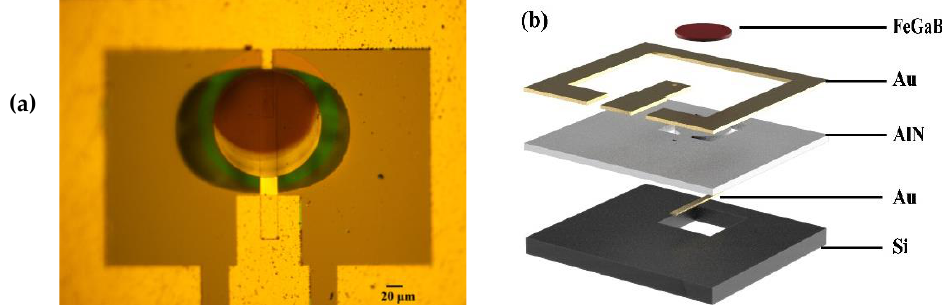
Figure 1. ( a ) Optical microscope photograph. ( b ) The structure and layers of the of the MEMS magnetoelectric antenna.